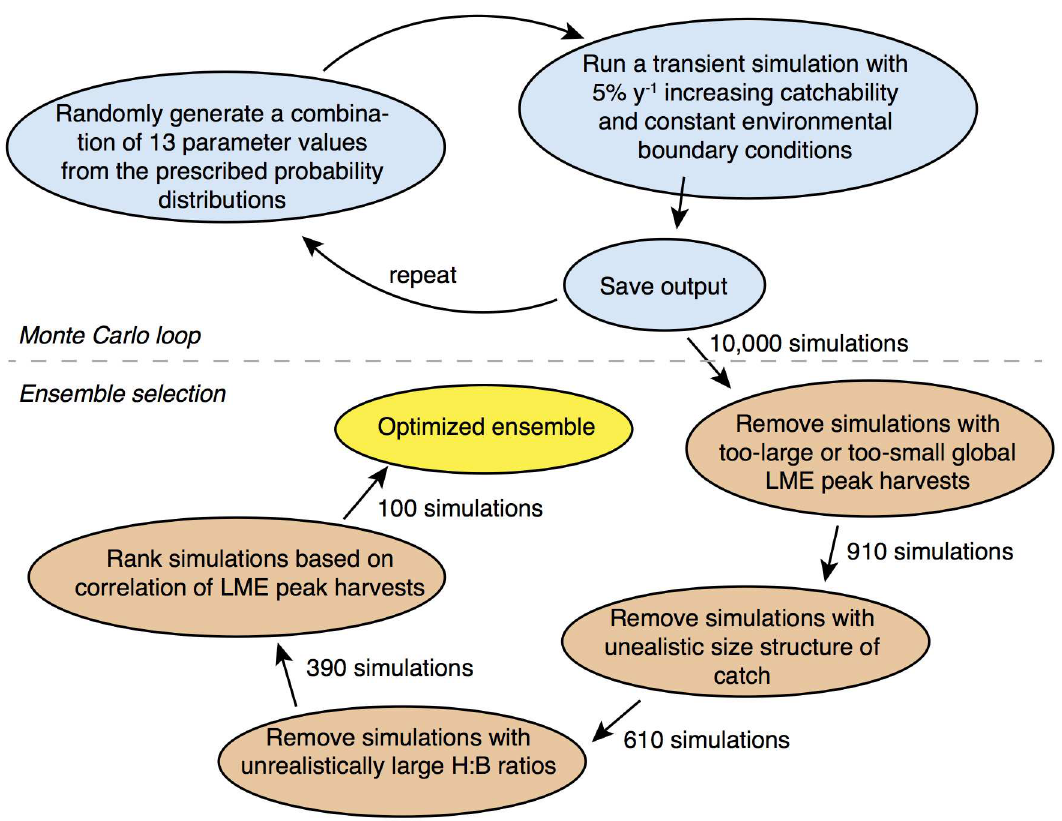
Fig 2. Schematic diagram of the Monte Carlo simulation procedure and selection of ensemble members.